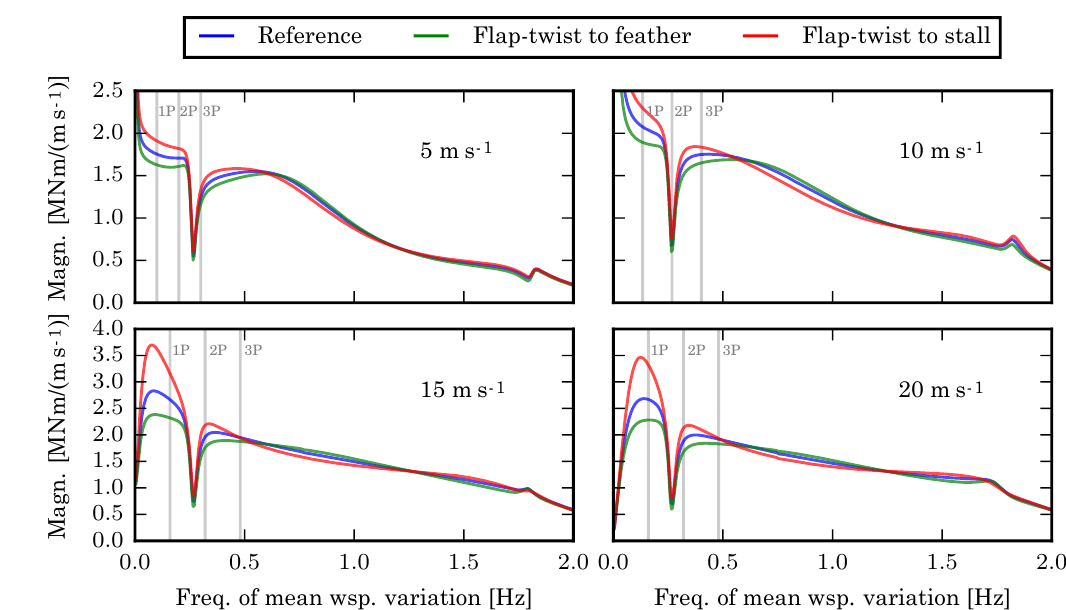
Figure 18. Frequency response of the flapwise blade root bending moment to mean wind speed variation between 0.0 and 2.0Hz for steady- state operation at mean wind speeds of 5, 10, 15, and 20ms − 1 . The coupled blades have a constant coefficient of γ y = ± 0 . 1.